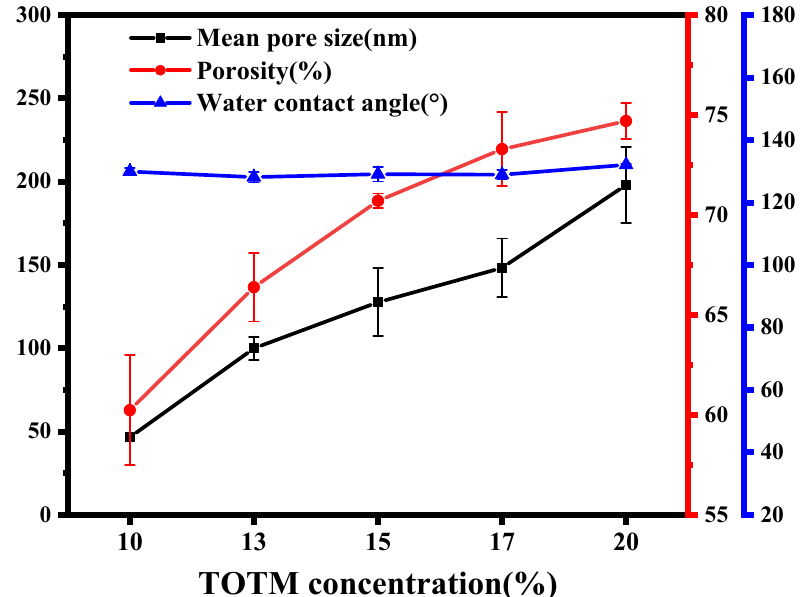
Figure 7. Mean pore size, porosity and water contact angle of ECTFE membranes prepared with different TOTM contents.